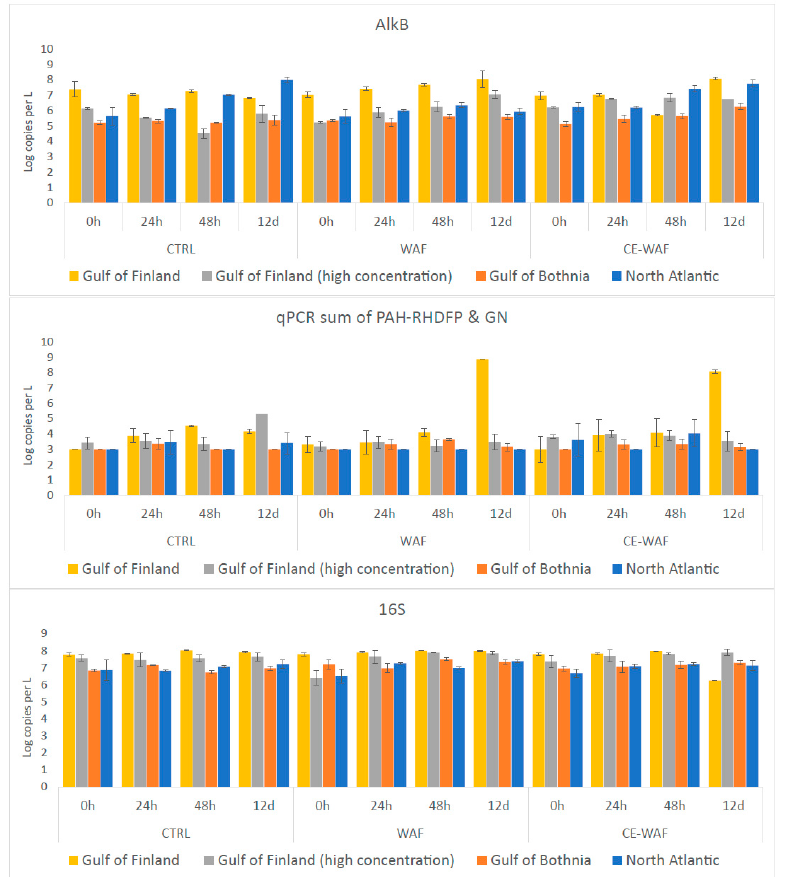
Figure 4. Gene copy numbers of alkB , PAH-RHD α (sum of gram-negative and gram-positive gene copies) and 16S rRNA genes for different experiments. Shown are mean values (n = 3), and error bars indicate standard deviation.